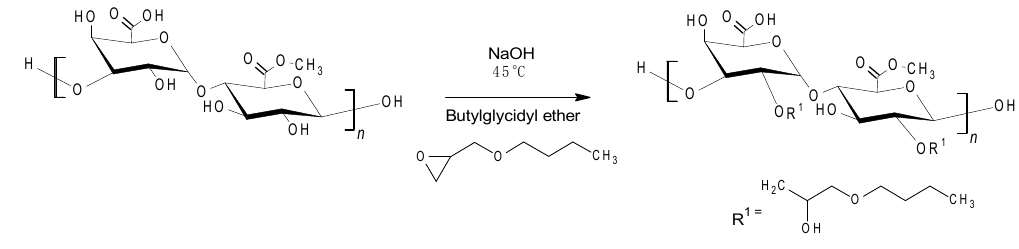
Figure 1. Synthesis of butylglyceryl pectin (P-OX4).